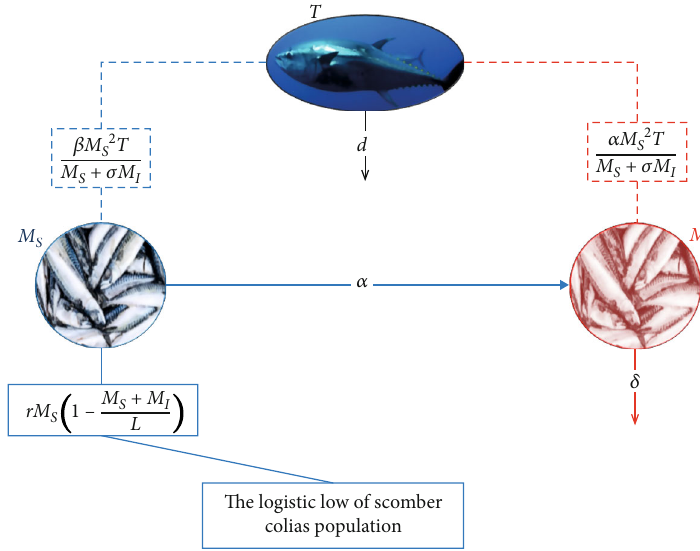
Figure 2: Interaction between susceptible Scomber colias, infected Scomber colias, and Thunnus